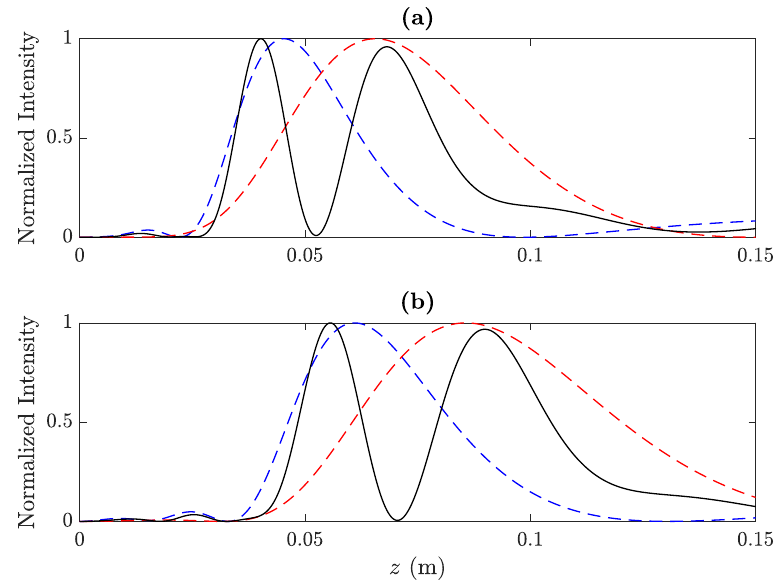
= 40 mm and F (cid:48) = 68 mm, and ( b ) the BiFZP 2 1 = 56 mm and F (cid:48) = 90 mm. In both cases, f = 250 0 2 1